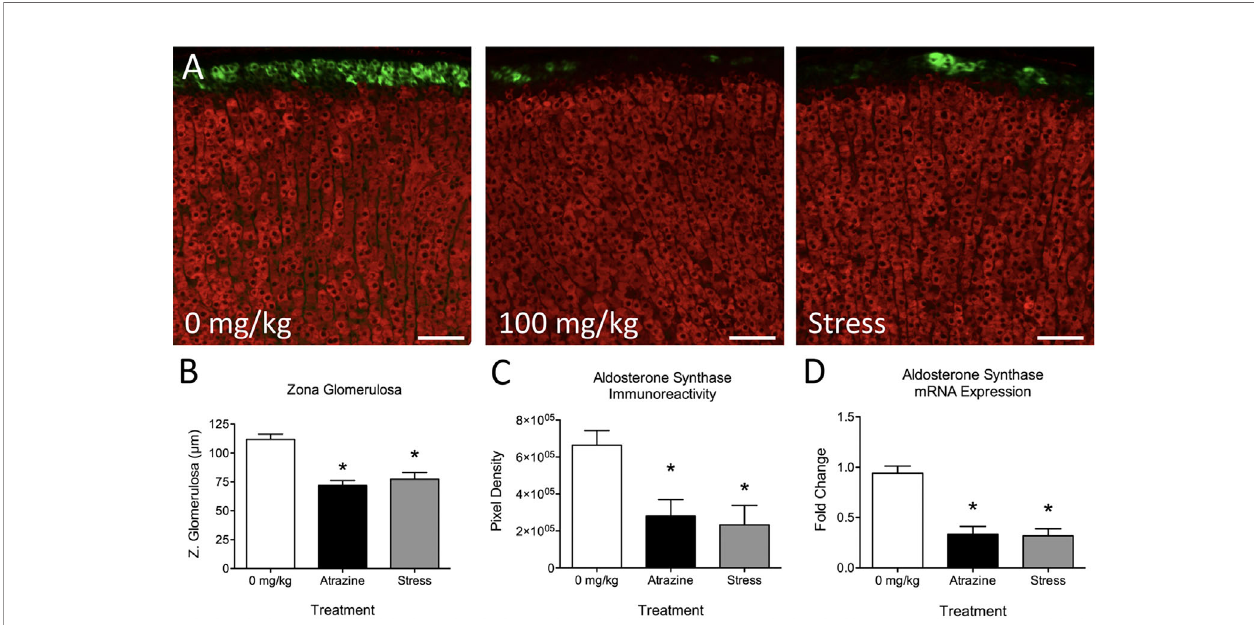
FIGURE 1 | Atrazine treatment and repeated restraint stress reduce zona glomerulosa thickness and aldosterone synthase immunoreactivity and expression. (A) Representative images of the adrenal cortex of vehicle, atrazine (100 mg/kg), and restraint stressed animals displaying aldosterone synthase (green) and 11 b - Hydroxylase immuno fl uorescence. (B – D) Histograms depicting (B) mean zona glomerulosa thickness, mean aldosterone synthase (C) immunoreactivity and (D) expression in adrenals of vehicle, atrazine (100mg/kg), and restraint stressed animals after 4 days of treatment. Data presented as the mean ± SEM. Asterisks signify difference from vehicle group ( P < 0.05).